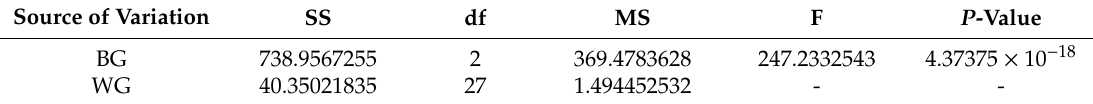
Number of observations = 30.